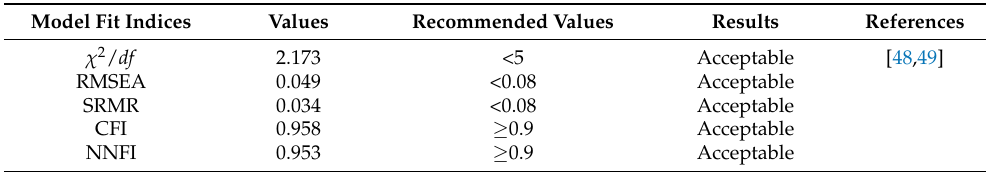
Table 3. Results of model fit indices for the measurement model.